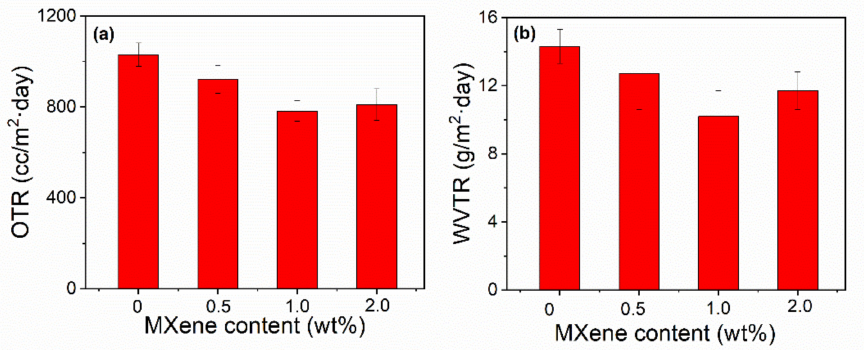
Figure 7. The gas barrier properties of PBAT/Ti 3 C 2 T X nanocomposite casting films. ( a ) OTR, ( b ) WVTR.